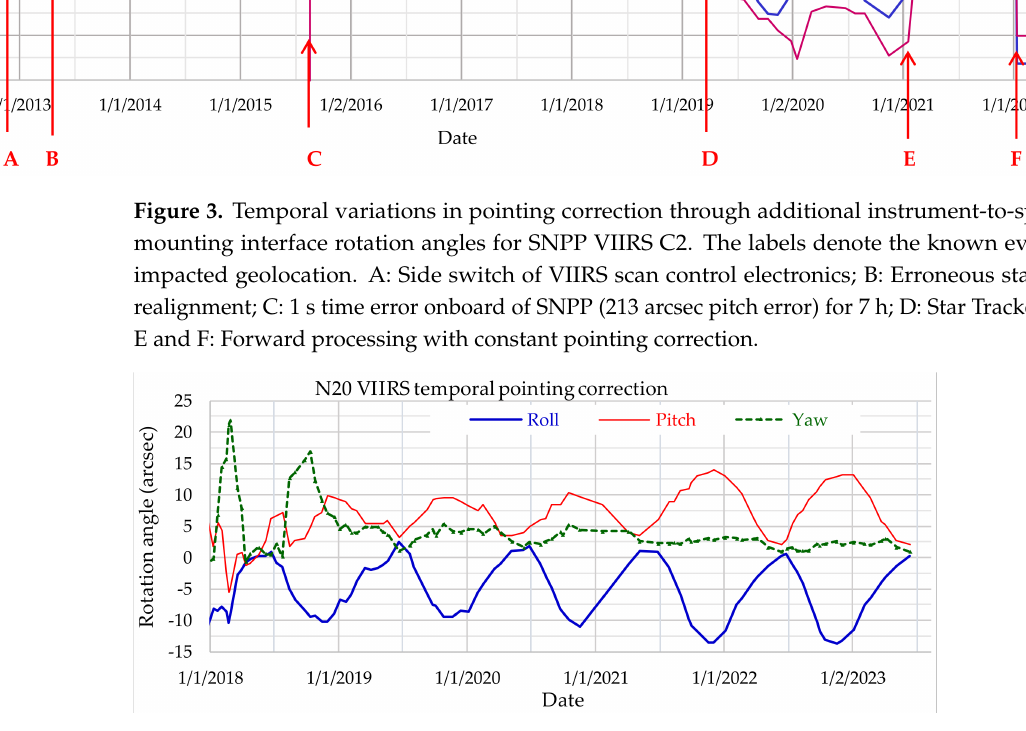
Figure 4. Temporal variations in pointing correction through additional instrument-to-spacecraft mounting interface rotation angles for NOAA-20 VIIRS